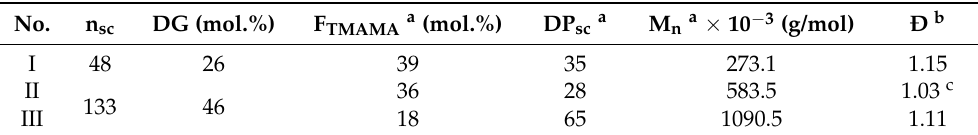
Table 1. Data for P(MMA- co -(BIEM- graft -P(TMAMA- co -MMA))) graft copolymers synthesized by ATRP. Data from